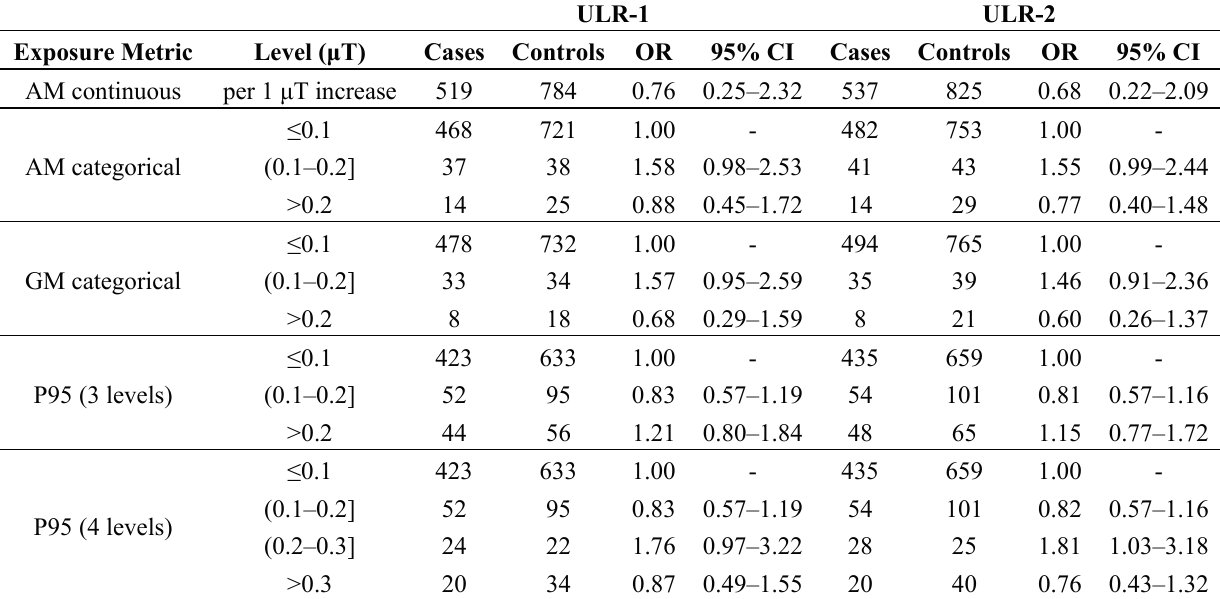
Table 5. ORs for childhood leukemia according to ELF-MF exposure (ULR adjusted * ). ULR-1 ULR-2 Exposure